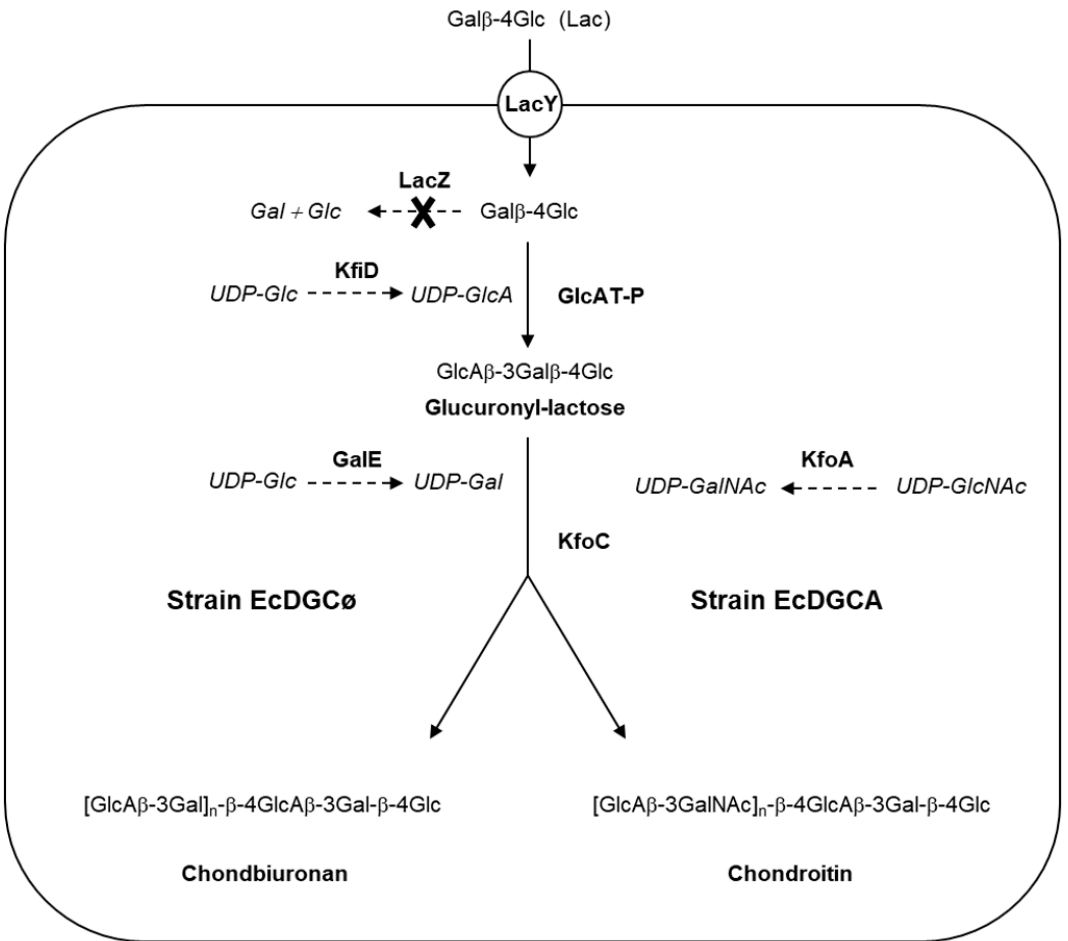
Figure 1. Synthesis of chondbiuronan and chondroitin in engineered Escherichia coli . Lactose (Lac) is taken up by lactose permease (LacY) and modified by the action of recombinant mouse β -1,3- glucuronyltransferase (GlcAT-P), leading to glucuronyl-lactose formation, UDP-GlcA being provided by the action of recombinant UDP-Glc dehydrogenase (KfiD) from the E. coli strain K5. Recombinant chondroitin synthase KfoC catalyses (i) synthesis of chondbiuronan in strain EcDGCø from UDP-GlcA and UDP-Gal constitutively produced by GalE or (ii) synthesis of chondroitin in strain EcDGCA from UDP-GlcA and UDP-GalNAc produced by recombinant epimerase KfoA. Genotypes: EcDGCø, strain DJ (pBS-kfoC, pBBR-kfiD); EcDGCA, strain DJ (pBS-kfoC, pBBR-kfiD, pBAD-kfoA).